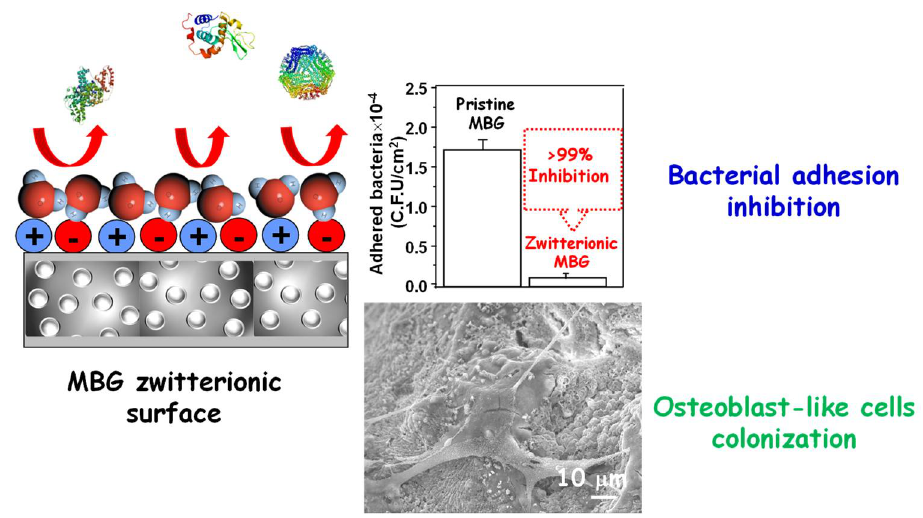
Figure 7. Performance MBG zwitterionic surfaces and biological characteristics, namely bacterial adhesion inhibition and osteoblastic-like colonization. Reproduced (adapted) from reference [145]. Copyright 2018 MDPI.